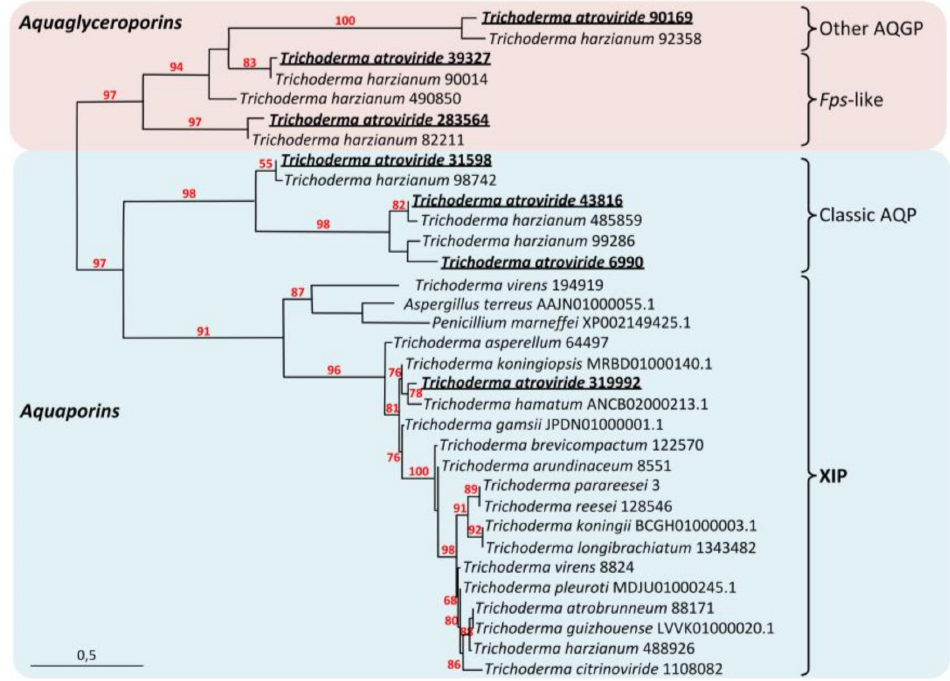
Figure 1. Phylogenetic analysis of XIP from the Trichoderma genera and selected fungal MIP. AQPs, classical aquaporins; AGPs, aquaglyceroporins; XIP, X-intrinsic protein. Red and blue squares indicate aquaglyceroporin and aquaporin subfamily nodes, respectively. The bootstrap values indicated at the nodes are based on 1000 bootstrap replicates. Branch values lower than 50% are hidden. The distance scale denotes the evolutionary distance expressed in number of nucleic acid substitutions per